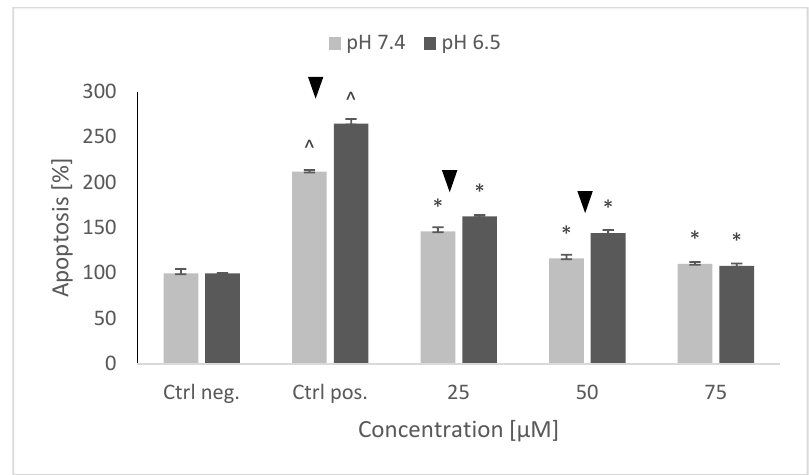
Figure 9. The level of apoptosis of SH-SY5Y cells after pretreatment with NRNPs pH and exposure to 6-hydroxydopamine. The whiskers are standard deviation. ^ p ≤ 0.05, Student t -test vs. the nega- tive control (Ctrl neg.; cells not treated with 6-OHDA), ▼ p ≤ 0.05, paired Student t -test, differences between different pH conditions (pH 7.4 vs. pH 6.5), * p ≤ 0.05, Student t -test vs. the positive control (Ctrl pos.; cells treated with 6-OHDA only, without any pretreatment); n = 3. NRNPs pH also decreased the rate of necrosis at pH 7.4, but this effect was not concen- tration-dependent. At pH 6.5, NRNPs pH were the most effective at the lowest concentration applied (25 μ M); the protective effect was lower at higher concentrations (Figure 10).